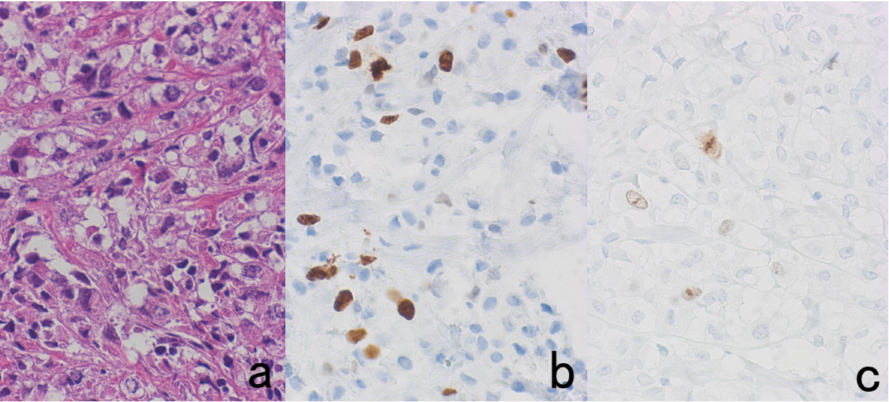
Figure 27. Loss of Ki-67 immunoreactivity in breast cancer (with foci of dystrophic calcification) by surface decalcification with 5% trichloroacetic acid for 1 h. ( a ): H&E, ( b ): Immunostaining without surface decalcification and ( c ): Immunostaining after surface decalcification with trichloroacetic acid. Surface decalcification significantly deteriorates Ki-67